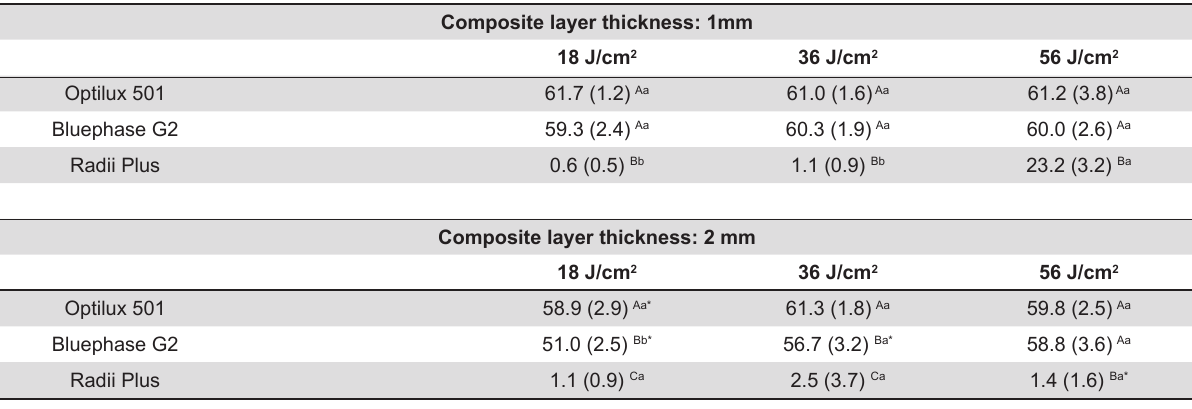
Radiant emittance values obtained with a radiometer (Cure Rite, DentsplyCaulk, Milford, DE, USA) Table 3- DC means (%) (standard deviation) of Lucirin-based RCs exposed to light from different curing units and delivered radiant exposure values